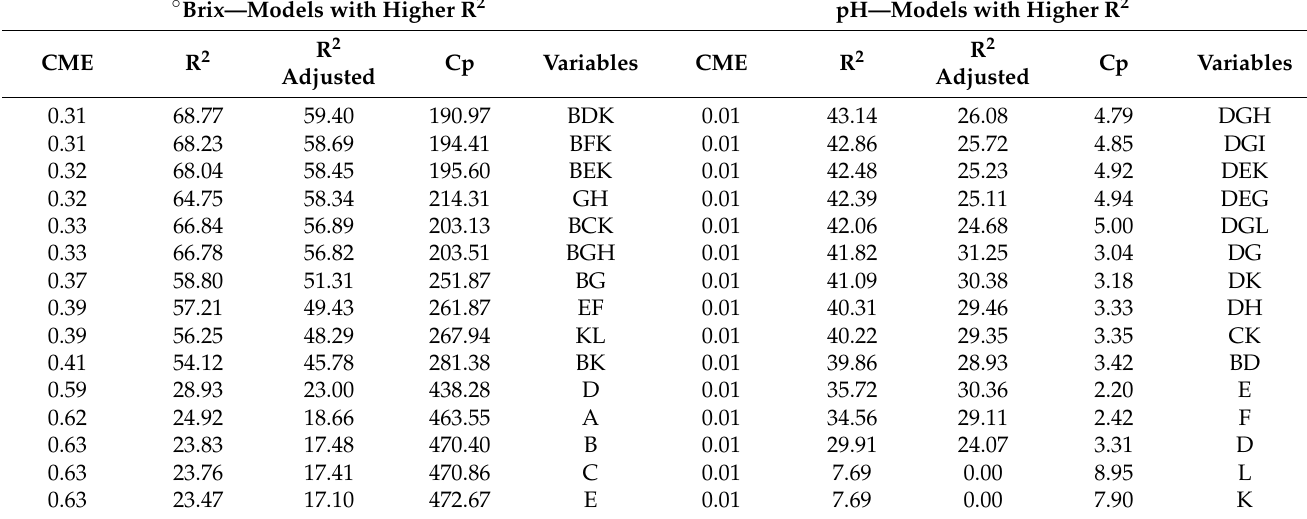
Table 4. Result of the best values of R 2 , adjusted R 2 (in%) and Cp of the models obtained for the sampled data from March 19, 2017. Designation of bands: A (B3); B (B4); C (B5); D (B6); E (B7); F (B8); G (B11); H (B12); I (Chlorophyll); J (GNDVI); K (NDMI); L